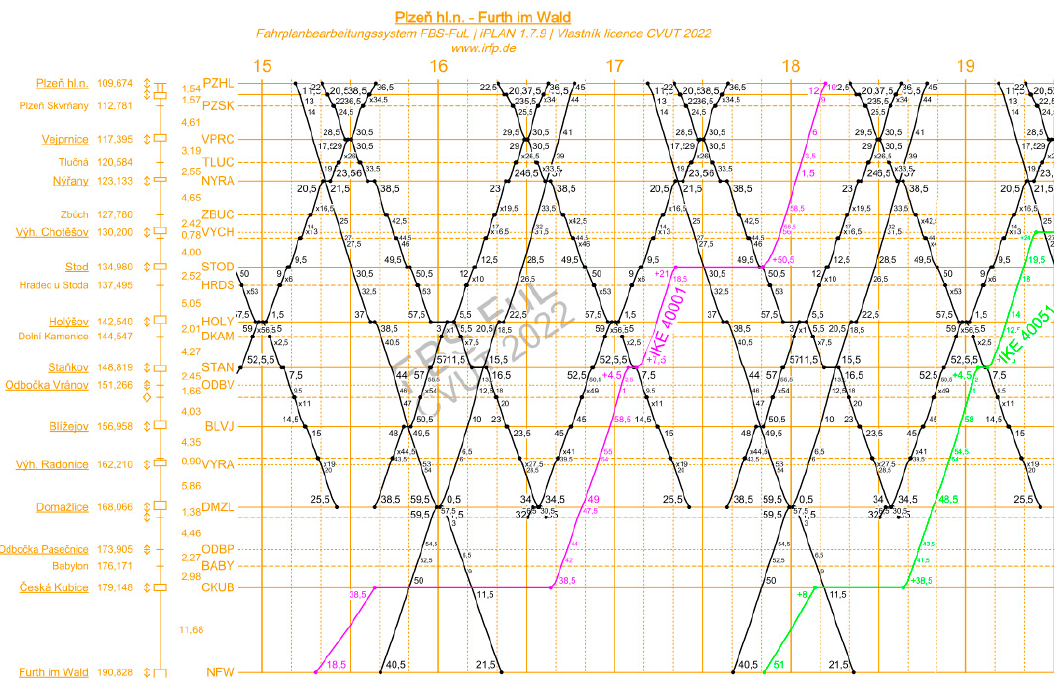
Figure 5. Proposed freight train paths on the rail line 180—direction to Plze ň (data: [1,26]). Source: Authors.